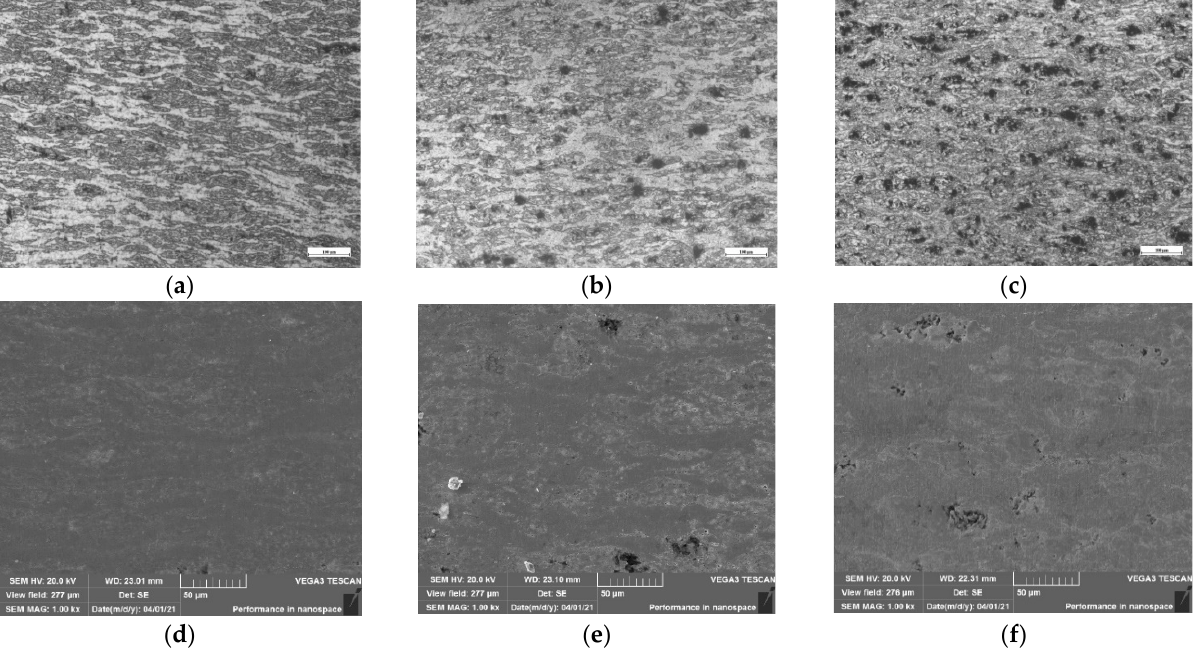
Figure 10. Microstructure of Zr-6Al-0.1B alloy at 1050 °C: ( a ) OM image of 0.01 s − 1 ; ( b ) OM image of 0.1 s − 1 ; ( c ) OM image of 1 s − 1 ; ( d ) SEM image of 0.01 s − 1 ; ( e ) SEM image of 0.1 s − 1 ; ( f ) SEM image of 1 s − 1 .